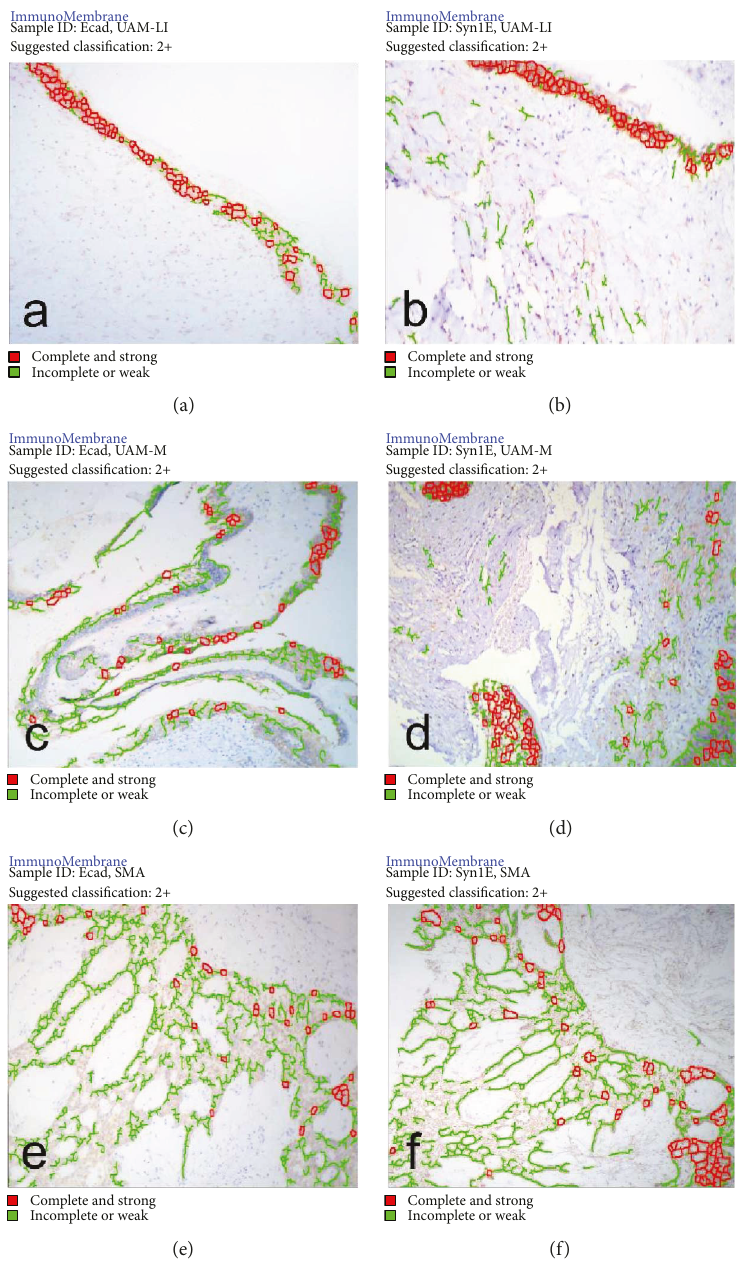
Figure 3: Ameloblastomas in which the membrane expression of E-cadherin and syndecan-1 were evaluated. (a) Membrane expression of E-cadherin in a luminal/intraluminal ameloblastoma. (b) Membrane intensity expression of epithelial syndecan-1 in an intraluminal/ luminal ameloblastoma. (c) Membrane intensity expression of E-cadherin in a unicystic ameloblastoma with mural invasion. (d) Membrane intensity expression of epithelial syndecan-1 in a unicystic ameloblastoma with mural invasion. (e) Membrane intensity expression of E-cadherin in a solid/multicystic ameloblastoma. (f) Membrane intensity expression of epithelial syndecan-1 in a solid/ multicystic ameloblastoma. The intensity of stromal expression was considered a